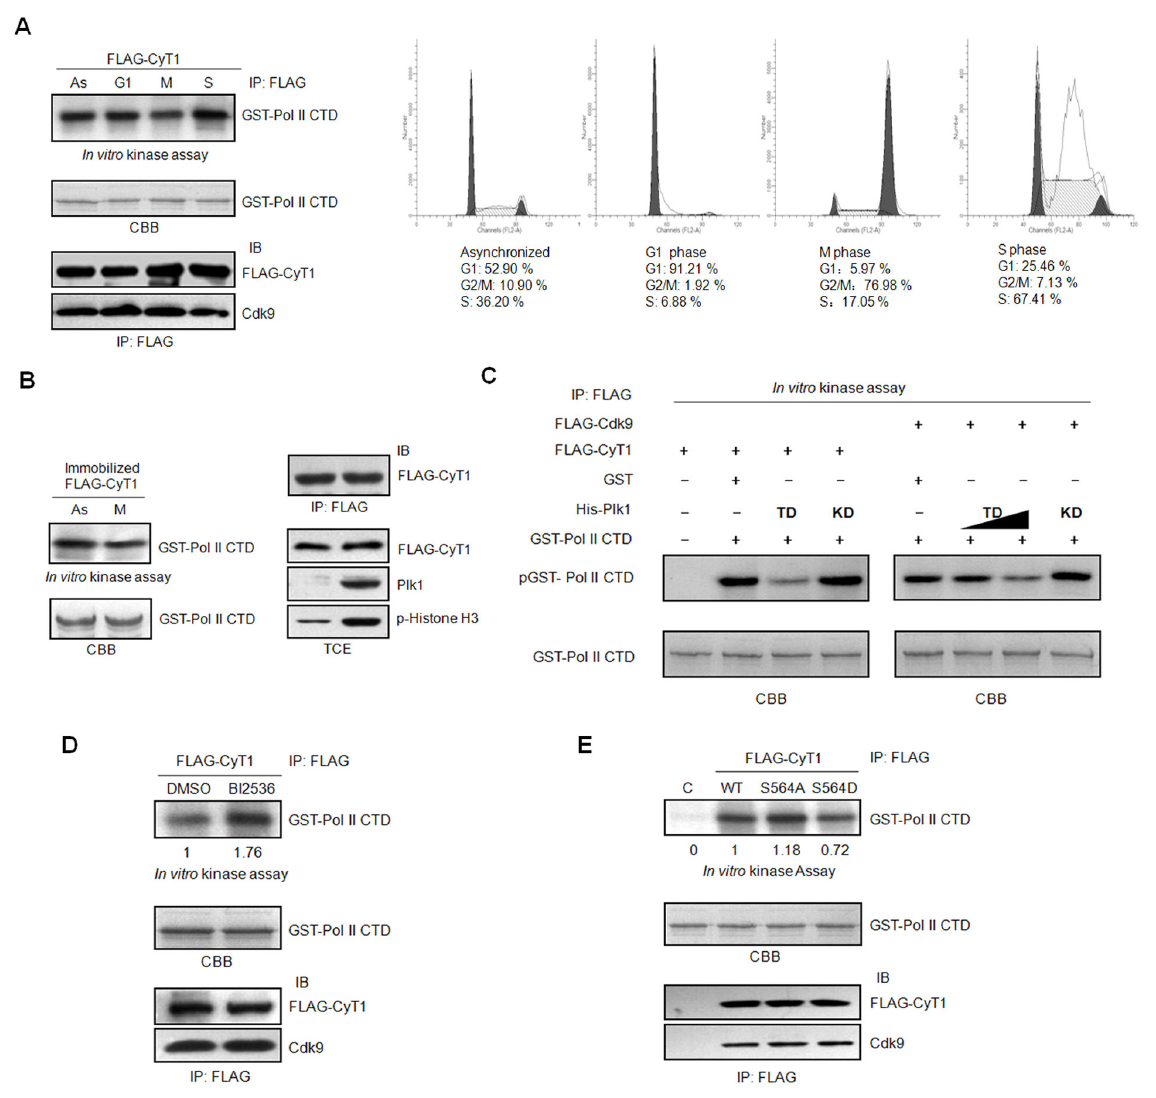
Figure 4. Plk1 inhibites the kinase activity of the P-TEFb complex. (A) In vitro kinase assay. HCT116 cells transfected with pCMV FLAG-cyclin T1 were synchronized into different phases as described in Material and Method. The synchronization of the cells was detected by FACS. Cell lysates were immunoprecipated with FLAG antibody. Half of the immunoprecipates were subjected to immunoblotting with Cdk9 and FLAG antibody. The other half of the immunoprecipates were then incubated with GST- RNA Pol II CTD in the presence of [γ- 32 P] ATP for the in vitro kinase assay. (B) FLAG-cyclin T1 over-expressed in 293T cells were immunoprecipated with FLAG antibody. The immunoprecipitated cyclin T1 complexes were preincubated with the lysates from HeLa cells either asynchronized or synchronized in M phase with cold ATP for the in vitro kinase assay, and washed with kinase buffer. Then the FLAG-cyclin T1 complexes were incubated with GST-RNA Pol II CTD and [γ- 32 P] ATP for a second round of in vitro kinase assay. The expression level of Plk1, phosphorylation of histone H3 in HeLa cells and the immunoprecipitated FLAG-cyclin T1 after incubating with Hela cell extracts and washed were detected by immunoblotting with the indicated antibody. (C) 293T cells were transfected with pCMV FLAG-cyclin T1 or pCMV FLAG-Cdk9 respectively. The cell lysates were immunoprecipitated with FLAG antibody and the immunoprecipitated complexes were subjected to in vitro kinase assay in the presence or absence of His-Plk1 TD or His-Plk1 KD with GST- RNA Pol II CTD as the substrate. (D) pCMV FLAG-cyclin T1 transfected 293T cells were treated with or without BI2536(1µM) for 3.5 h before harvest. The FLAG-cyclin T1 complexes were immunoprecipated with FLAG antibody and subjected to in vitro kinase assay with GST-RNA Pol II CTD as the substrate. Equal amount of the immunoprecipated FLAG-cyclin T1 and Cdk9 was shown. (E) FLAG-tagged cyclin T1, cyclin T1 S564A, cyclin T1 S564D over-expressed in 293T cells were immunoprecipitated with FLAG antibody and incubated with GST- RNA Pol II CTD and [γ- 32 P] ATP for the in vitro kinase assay. The immunoprecipated FLAG-cyclin T1 and Cdk9 were subjected to immunoblotting. doi: 10.1371/journal.pone.0072289.g004 PLOS ONE |